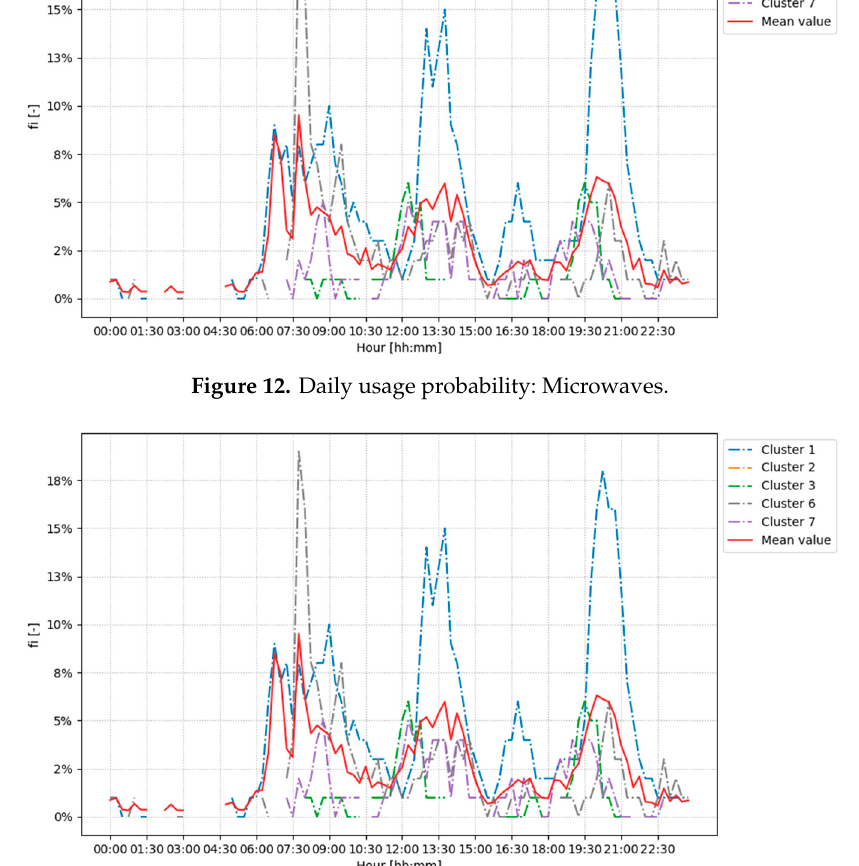
Figure 13. Load profiles of monitored households’ clusters.